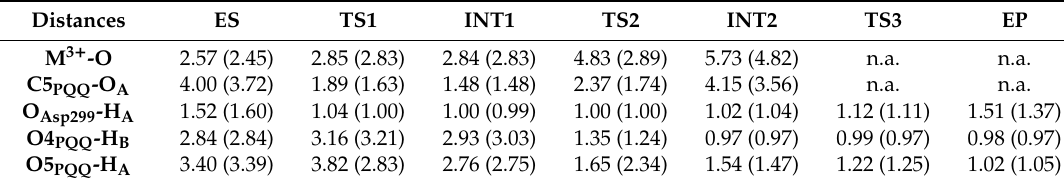
Table 1. Geometrical parameters obtained for the isolated stationary point along the reaction mechanism of Ce 3 + -MDH and Eu 3 + -MDH (in parenthesis) [105,106]. Data not available, due to the release of the product, are indicated with “n.a.” All values are in Å.